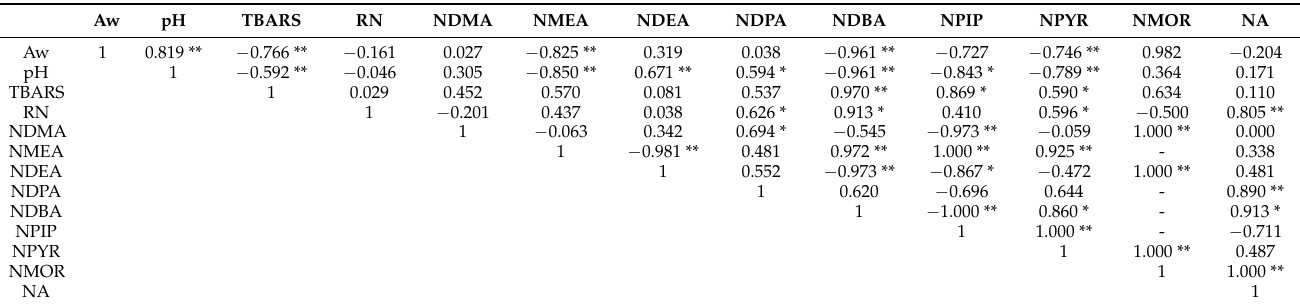
Table 4. Correlation between Aw, pH, TBARS, residual nitrites, NDMA, NMEA, NDEA, NDPA, NDBA, NPIP, NPYR, NMOR and NA in Larou of artisanal and industrial origin.